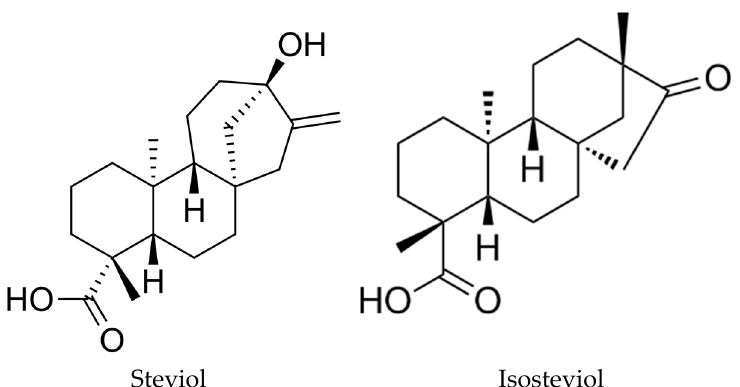
Figure 8 . Chemical structure of steviol and isosteviol. Figure 8. Chemical structure of steviol and